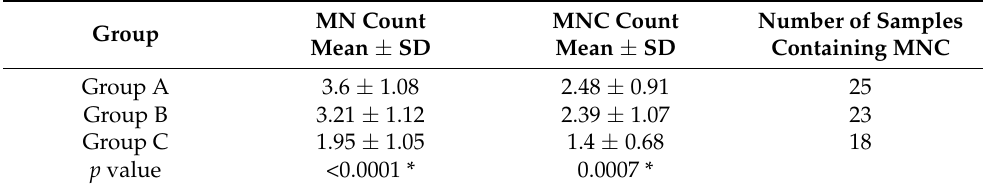
Table 2. Mean values of the MN and MNC count in the study groups.